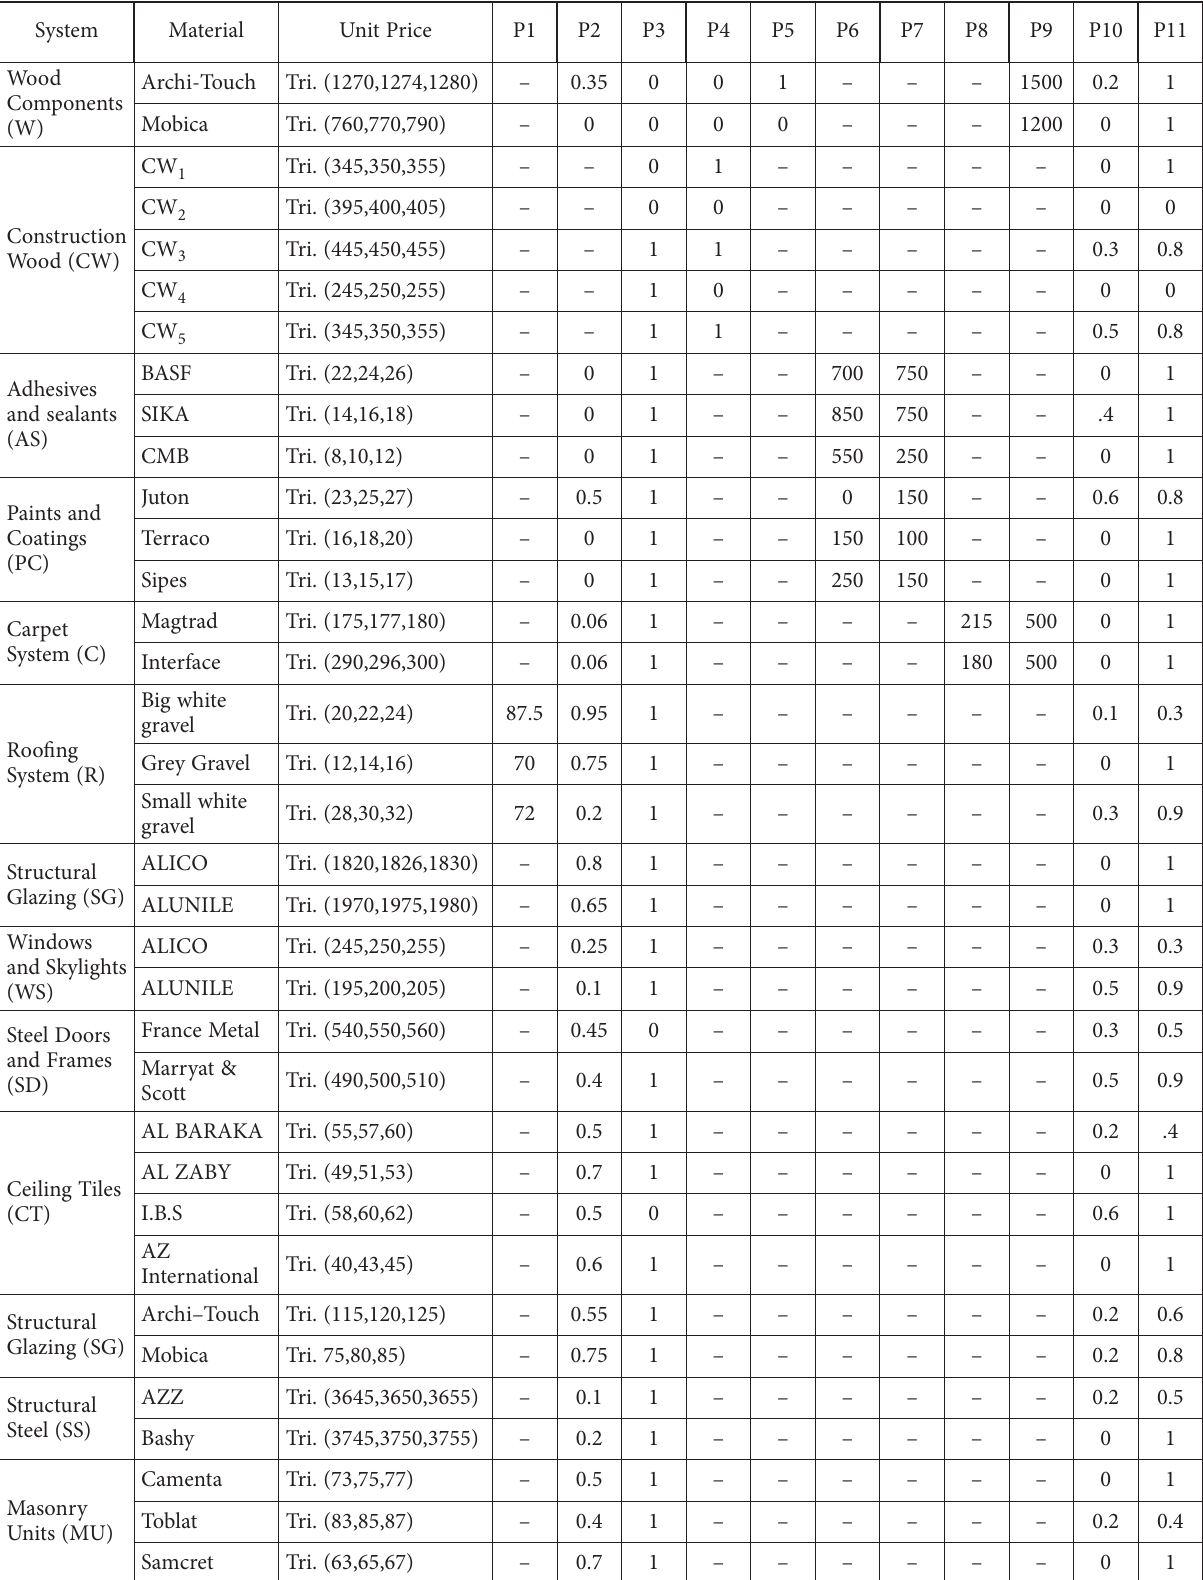
Table 3. Characteristics of materials